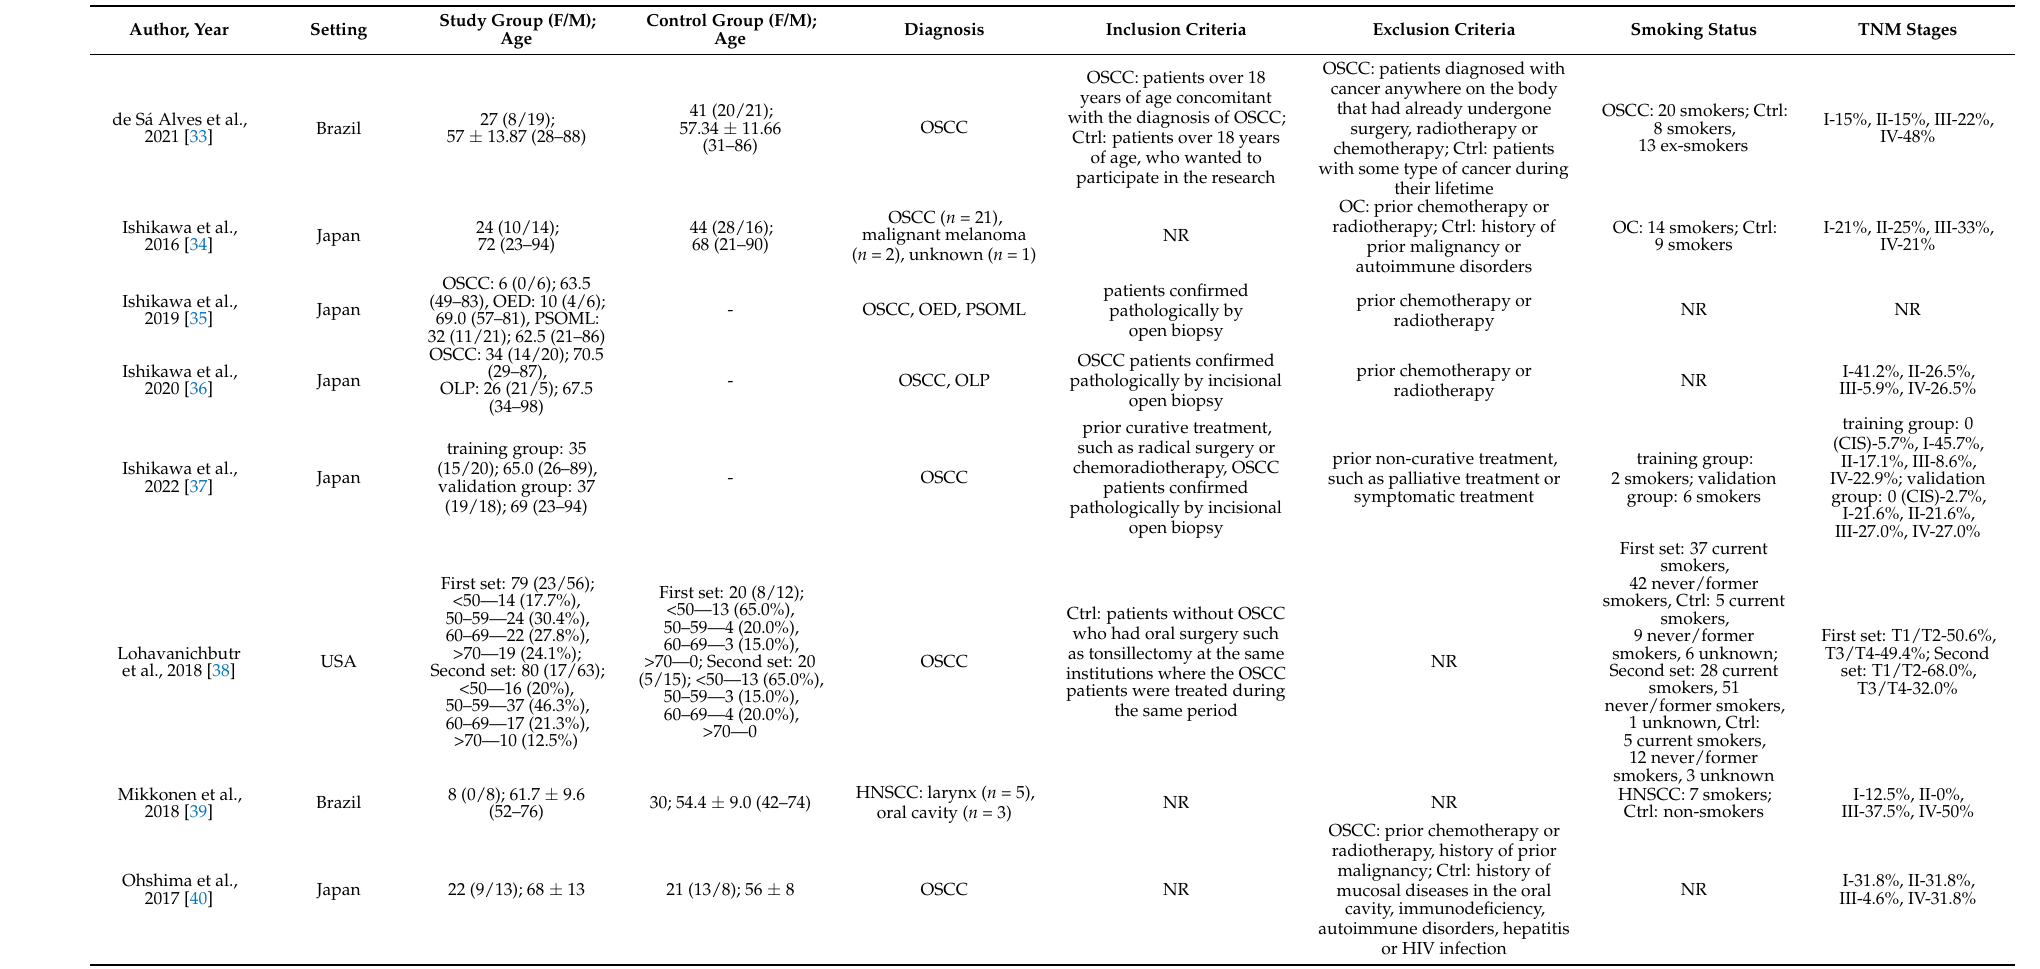
Table 1. General characteristics of included